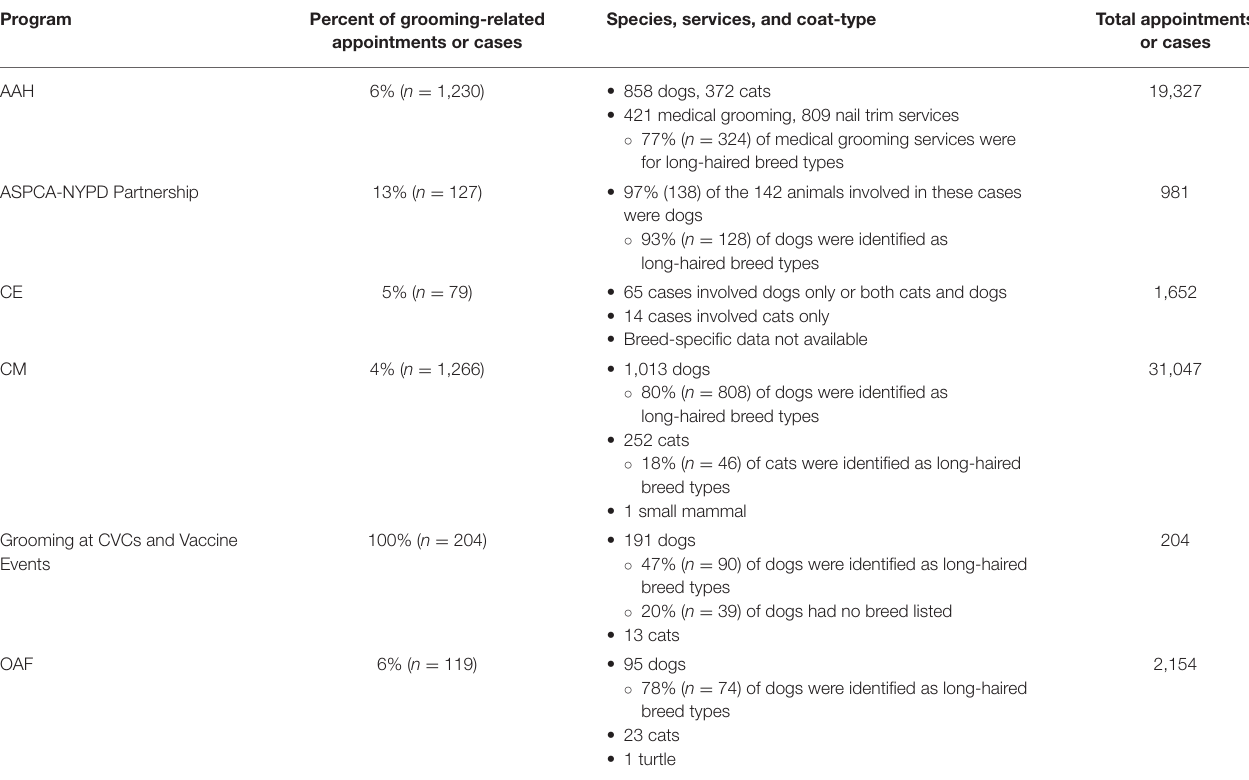
TABLE 1 | Number of appointments or cases per ASPCA program and the percentage involving grooming-related omissions of care and/or related services. Program Percent of grooming-related Species, services, and appointments or cases